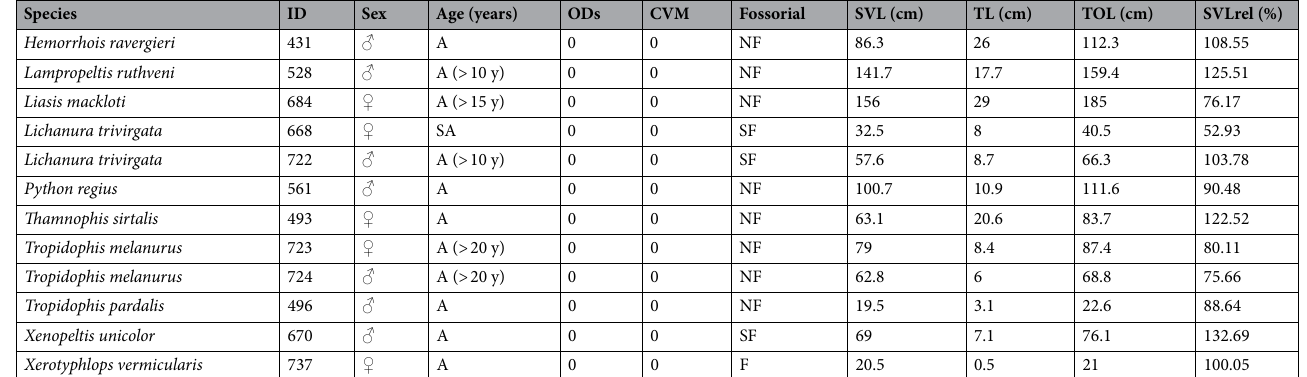
Table 1. The list of studied specimens in alphabetical order with details about the sex, age, presence of osteoderms, caudal vertebrae modifications, ecology, body size and relative body size. ID, identity of the specimen; ODs, osteoderms; CVM, caudal vertebrae modifications; SVL, snout-vent length; TL, tail length; TOL, total body length; SVLrel, relative body size; ♀ , female; ♂ , male; 0, absent; 1, present; F, fossorial; SF, semi-fossorial; NF, not fossorial; A, adult; SA, subadult; JUV, juvenile.